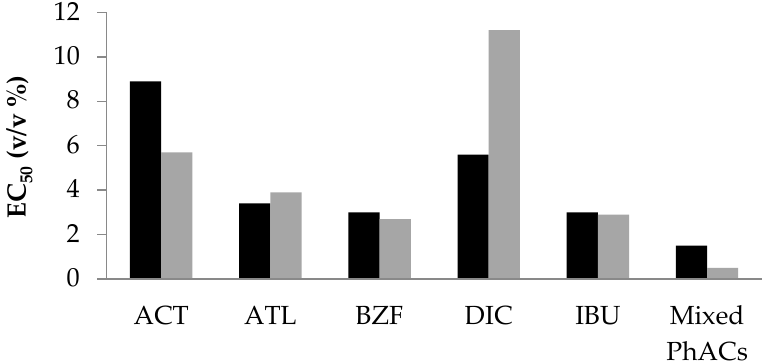
Figure 3. Values of EC 50 ( v/v %) determined through acute toxicity assays with V. fischeri for experi- ments performed with solutions of isolated or mixed PhACs. (cid:4) Untreated solutions. (cid:4) Solutions irradiated at 254 nm over 120 min.